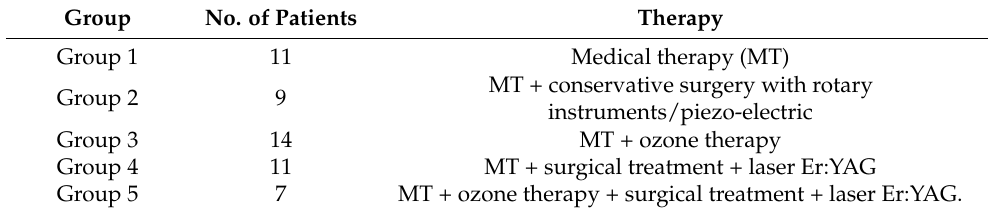
Table 1. Group distribution of the patients, the number of patients treated in each group, and their therapies.